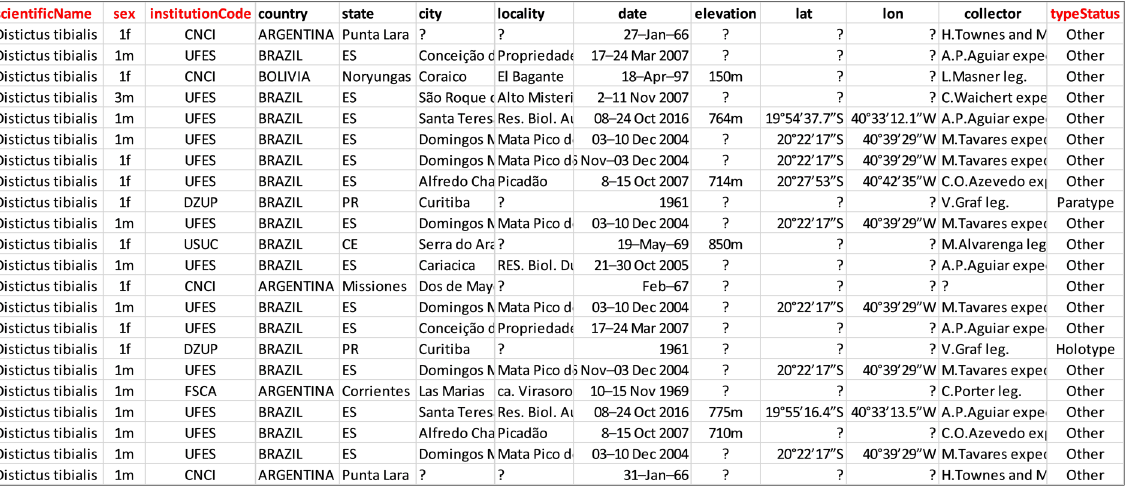
Fig. 1. Spreadsheet data from some of the specimens of Distictus tibialis (Brullé, 1846) cited in Supeleto et al. (2019). Mandatory columns and column names in the Gridit software marked in red.